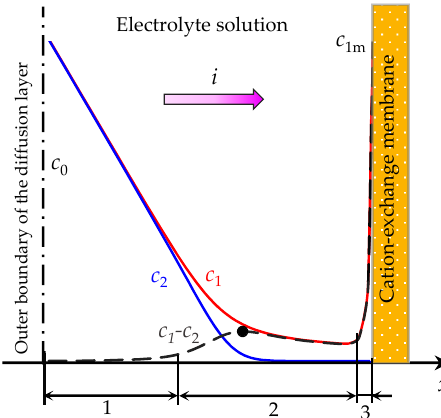
Figure 1. Schematic concentration profiles of cations ( c 1 , the red line) and anions ( c 2 , the blue line), the difference in the concentration of positive and negative ions ( c 1 - c 2 , the dashed line) in the diffusion layer adjacent to the surface of a cation-exchange membrane [6]. The current density, i , is flowing across the system; the electrolyte concentration in the solution bulk is denoted by c 0 ; the cation concentration at the solution/membrane interface is denoted by c 1m . The numbers indicate different regions of the diffusion layer: the electroneutral region (1), the extended (2) and the quasi-equilibrium (3) parts of the space charge region (SCR). The black dot denotes the local maximum of the extended SCR.